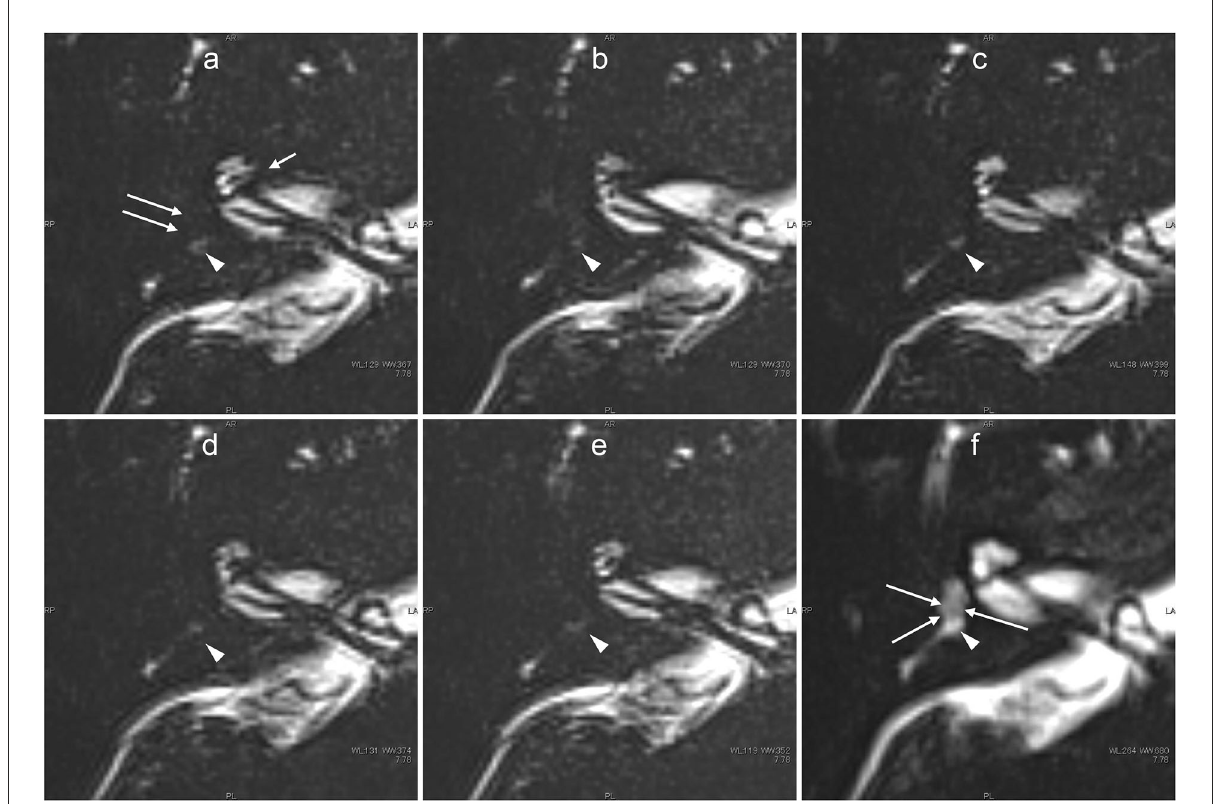
FIGURE9 Images obtained from the male patient aged in his 40’s with a history of acute low-tone sensorineural hearing loss 3 years previously but no history of vertigo who was currently asymptomatic. 3 years earlier, the patient had been shown to have cochlear endolymphatic hydrops by previous contrast-enhanced MR imaging using an intravenous gadolinium-based contrast agent. In this patient, five ultra-heavily T2-weighted images (6min scan with a TE of 3,200ms) were obtained serially (a–e) , and a 3min scan image with a TE of 540ms was obtained as a less sensitive scan to delineate the labyrinthine anatomy (f) . From the initial scan obtained ∼ 30min after intratympanic administration of 17 O-labeled water (a) , the signals for the vestibular signal (arrows) and anterior part of the basal turn in the cochlea (short arrow) were almost completely lost because of the distribution of 17 O-labeled water. Note that most of the vestibule showed a slightly decreased signal even in the less sensitive image with a TE of 540ms (arrows, f ). The concentration of intralabyrinthine 17 O-labeled water was higher in this patient than in the volunteers. The signal for the posterior ampulla (arrowheads in a – f ) decreased gradually from the initial phase (a) to the third phase (c) . From the third phase (c) to the fifth phase (e) , almost no signal was observed in the posterior